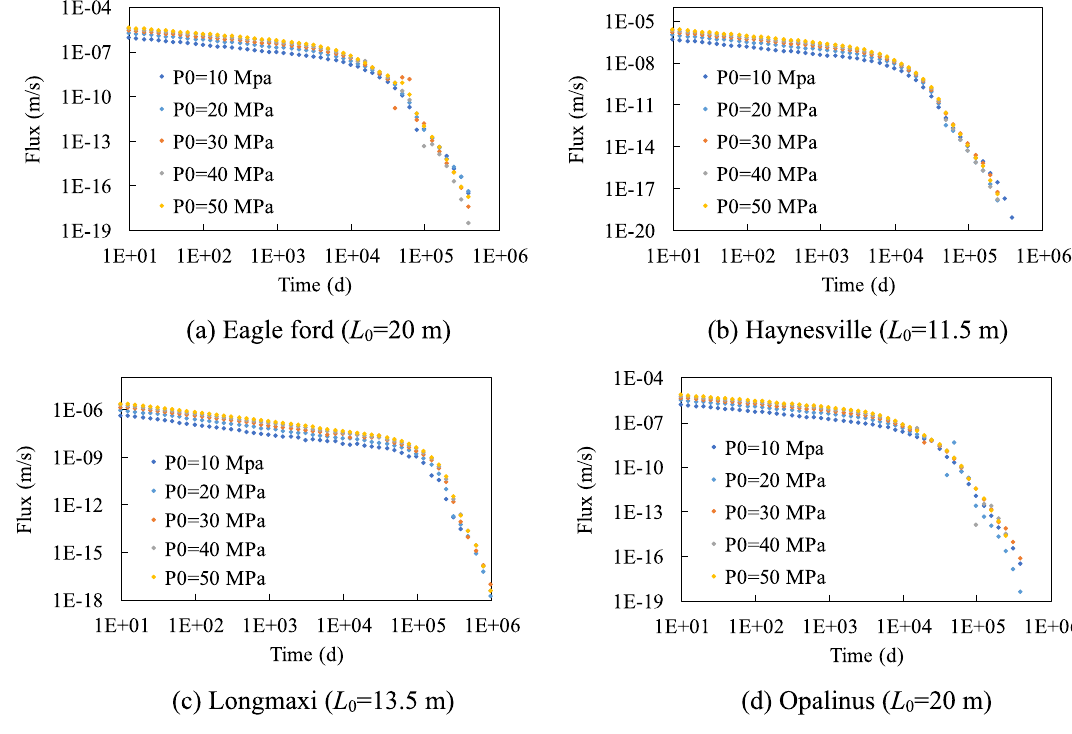
Figure 4. Influence of initial pressure on the gas production rate.